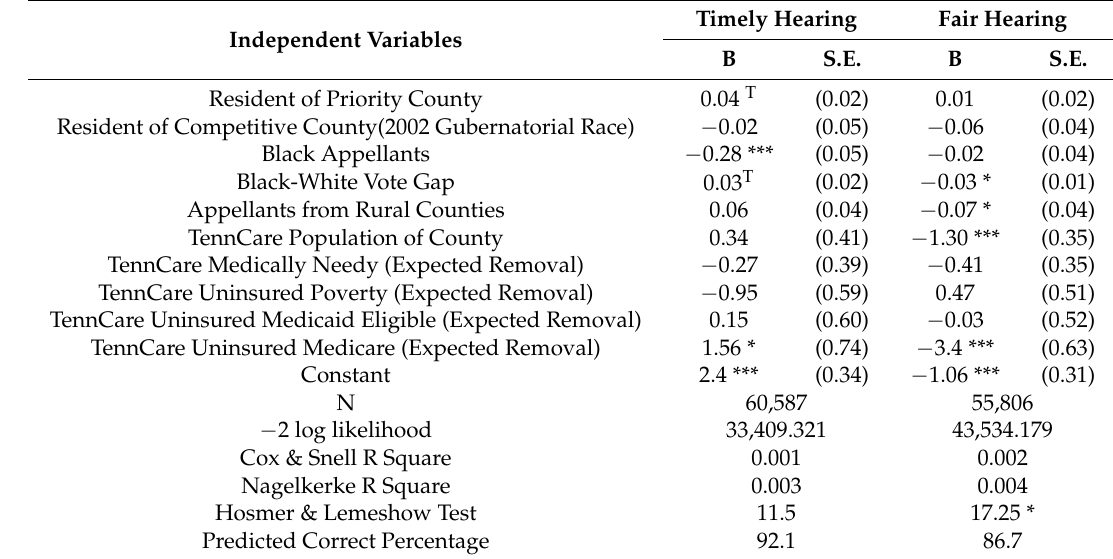
Table 2. Binary Logistic Regressions for TennCare Appeals